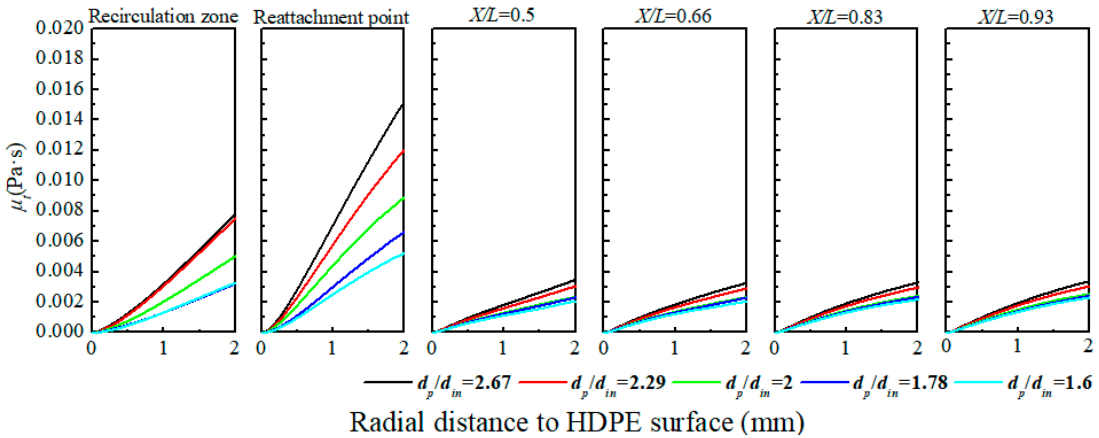
Figure 27. Turbulent viscosity ( μ t ) at different axial positions of different cases.